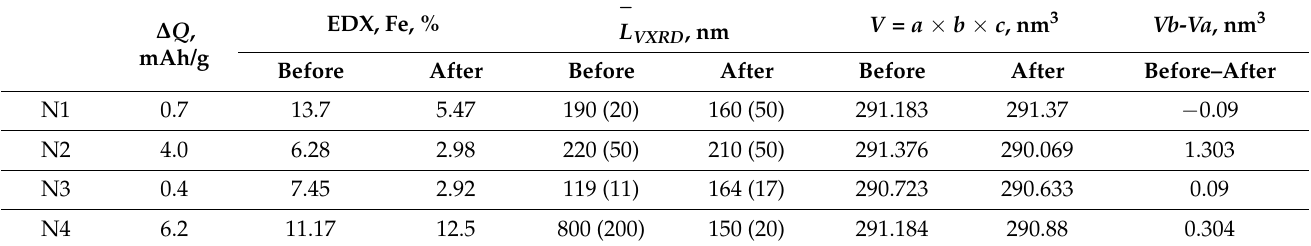
Table 5. Results of degradation of the test LiFePO 4 cathodes after 100-fold cycling at 1C discharge rate; the extrapolated prediction of their cycling was given above in Table 2. ∆ Q —capacity reduc- tion, Fe atomic % obtained using EDX (Section S1), cell volumes before and after cycling, Vb-Va— their